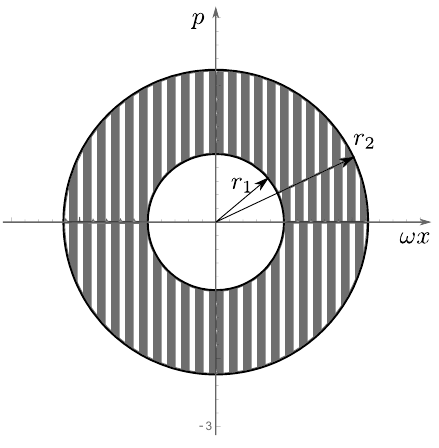
Figure 1 . Phase space picture of excited state described by